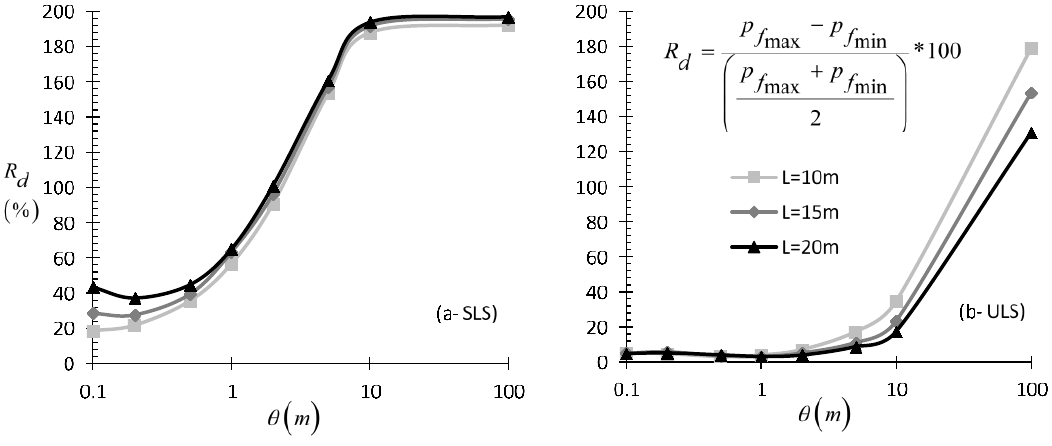
Figure 4. Chart indicating the relative percentage di ff erence R d between the minimum and maximum p f value for θ values ranging from 0.1 to 100 m and pile length L = 10, 15, and 20 m for ( a ) the SLS and ( b ) the ULS